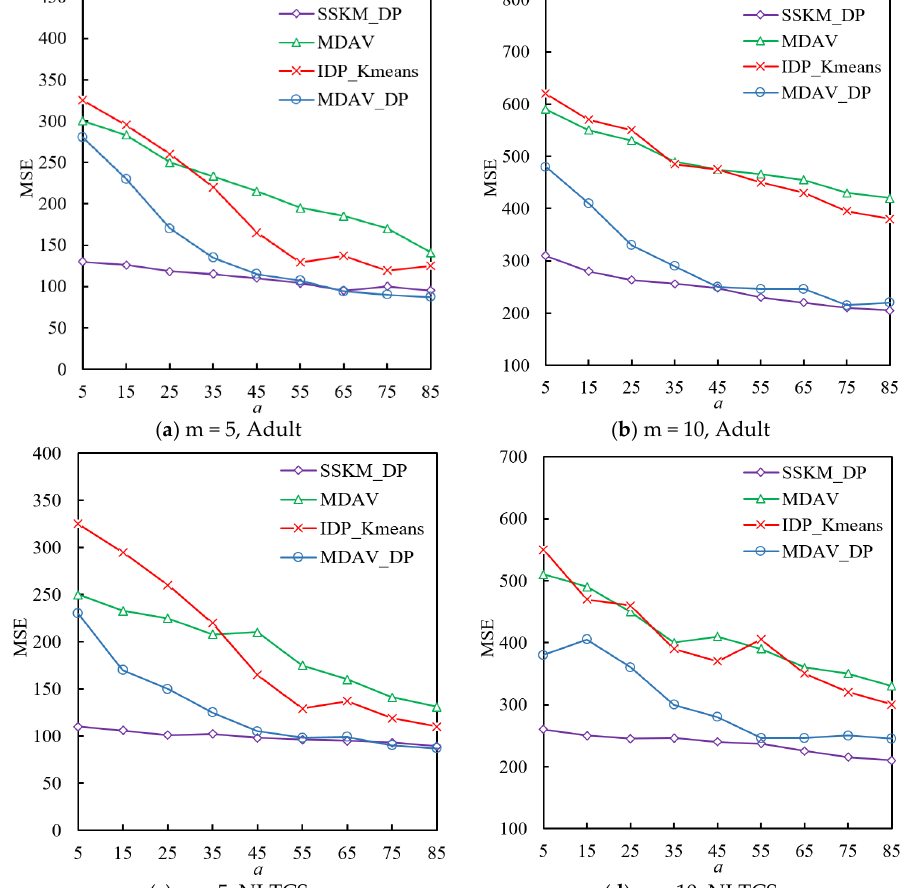
Figure 7. SSE trends of the four algorithms for Adult and NLTCS datasets.